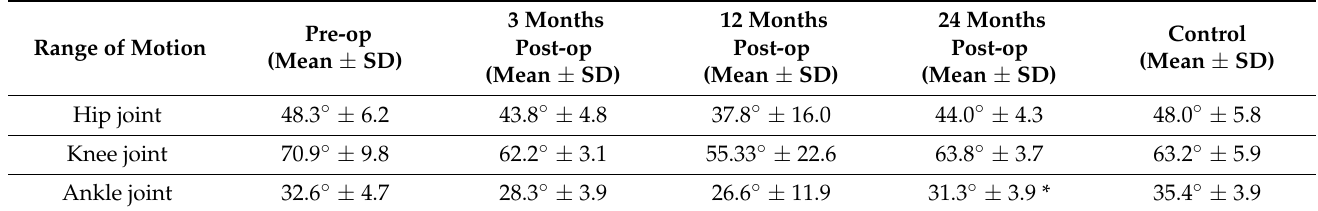
Table 2. The range of motion of the hip, knee, and ankle joints was measured in patients at four endpoints and compared with the control. * indicates p < 0.05 for 24 months post-op vs. control.